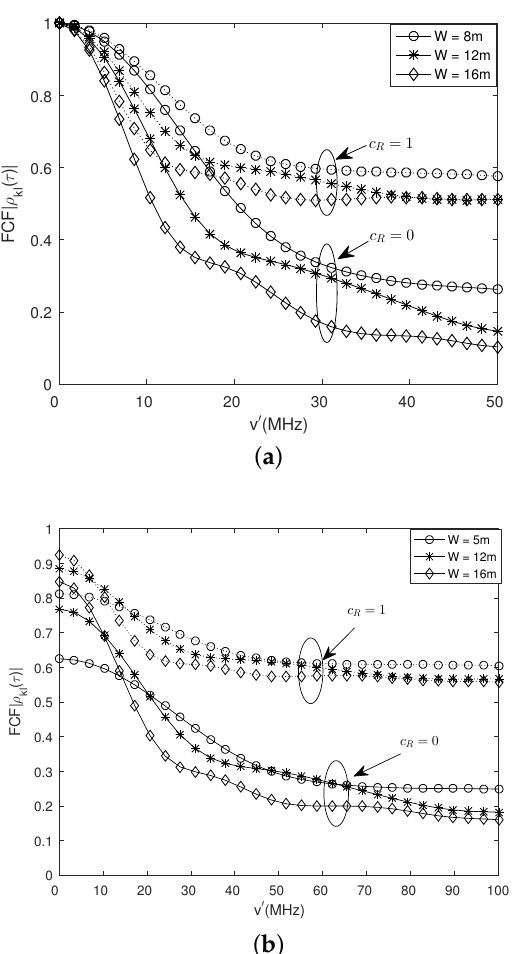
Figure 15. FCF of SRT and without arched ceiling for geometric parameters. ( a ) FCF of SRT ( b ). FCF of SRT without ceiling.